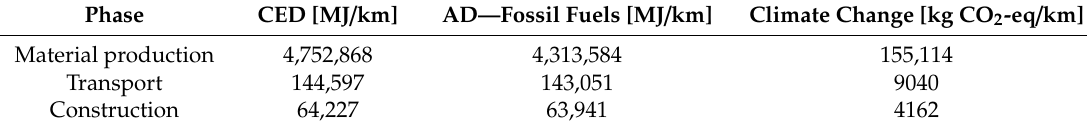
Table 9. The impacts of the e-road construction per functional unit, i.e., per 1 km.